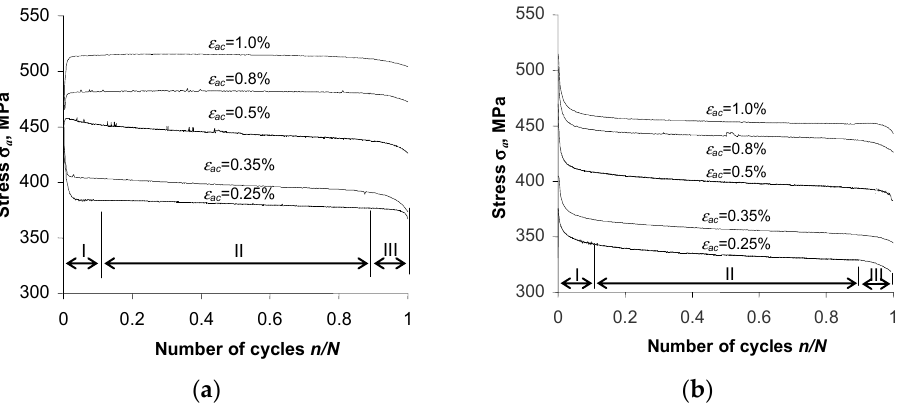
Figure 9. Stress variations σ a versus n / N at different strain levels ε ac : ( a ) as-received specimens, ( b ) strained specimens.